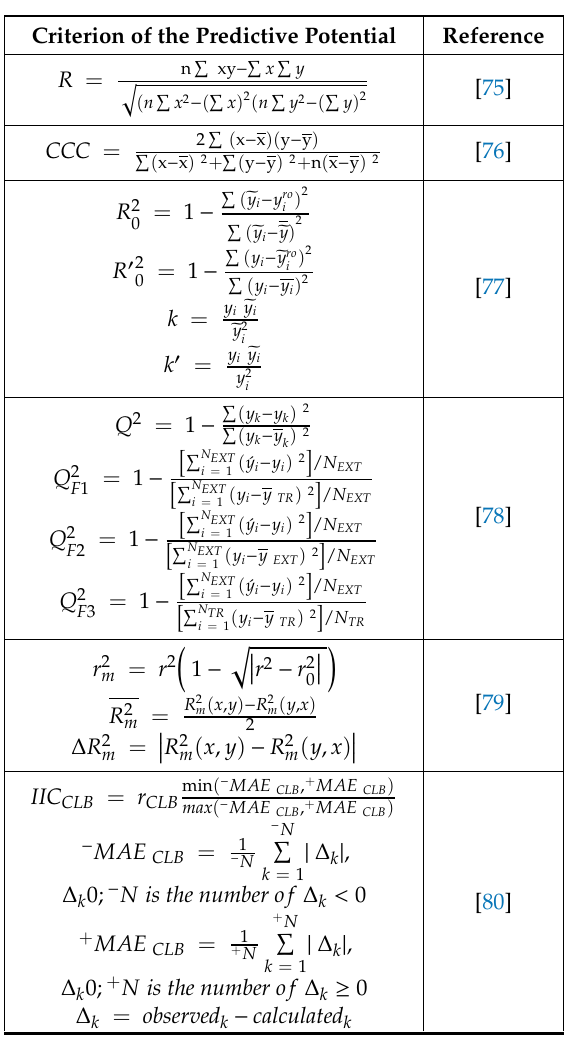
Table 3. Statistical criteria of the predictive potential for the quantitative structure–property activity relationships (QSPR / QSAR)